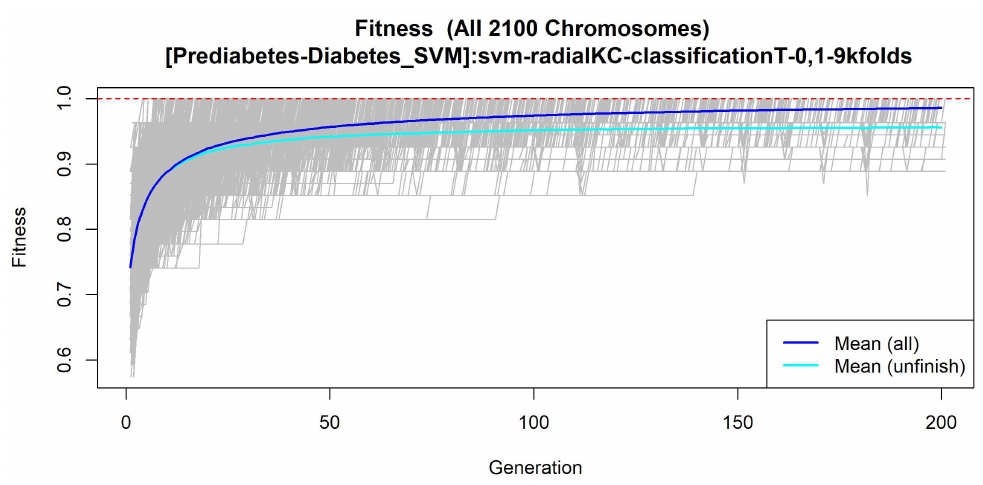
Figure 9. Gene frequency and gene rank stability in the models are ascertained by applying GA with SVM to select the main features from the Prediabetes-T2DM dataset. ( A ) Gene frequency allows observing the number of times each feature appears in the models. ( B ) Gene rank allows observing the stability and frequency of each feature within the models and orders them by rank.